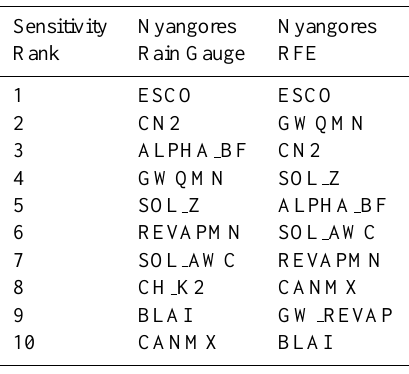
Table 5. Sensitivity ranking of parameters for the SWAT modeling of flow using gauge data and estimated